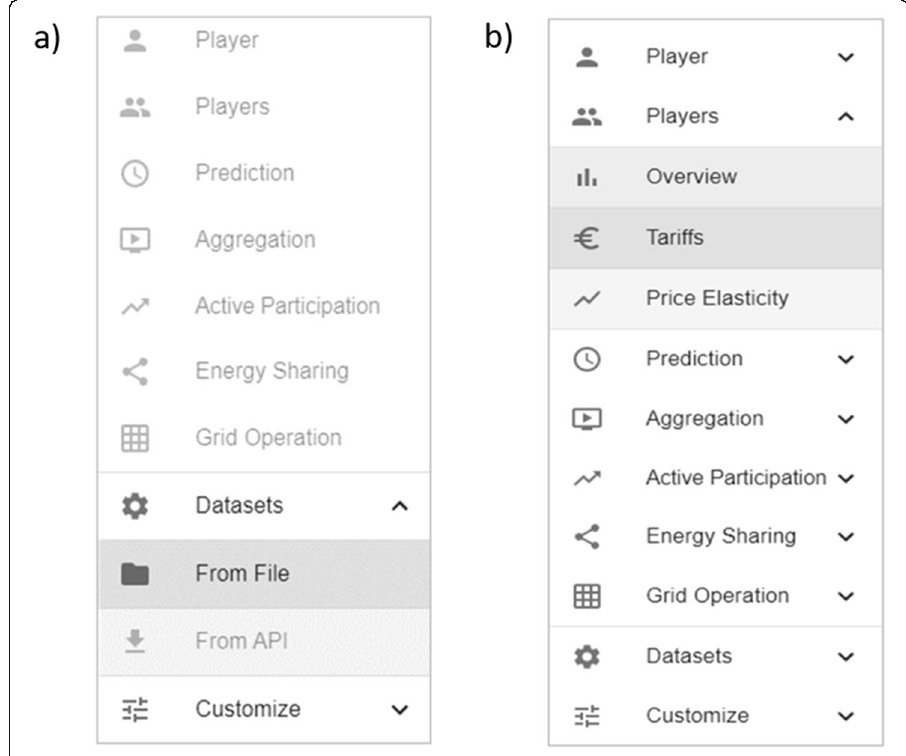
Fig. 2 Side menu of the application: a with locked services, b with unlock